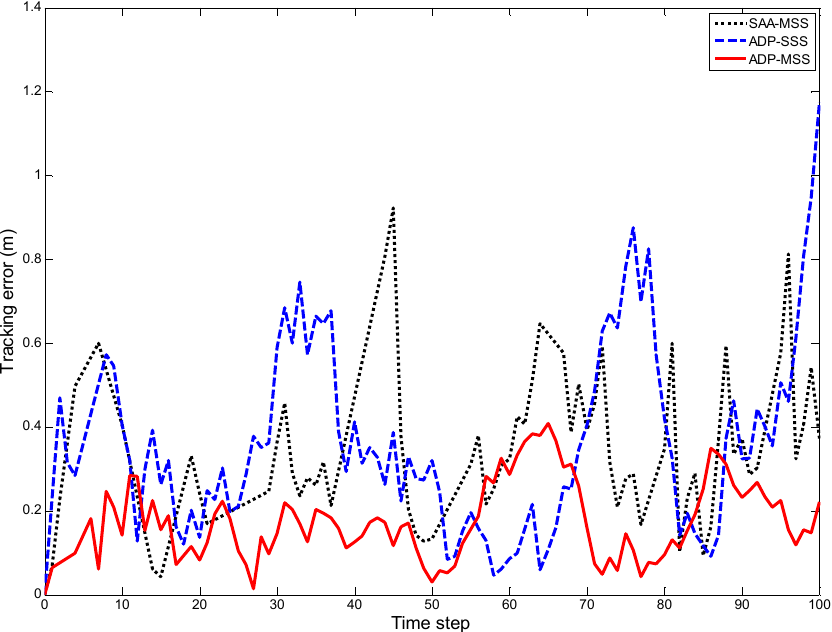
Figure 6. The tracking error when the variance of the measurement noise was 0.05 and the target speed was 5 m/s.